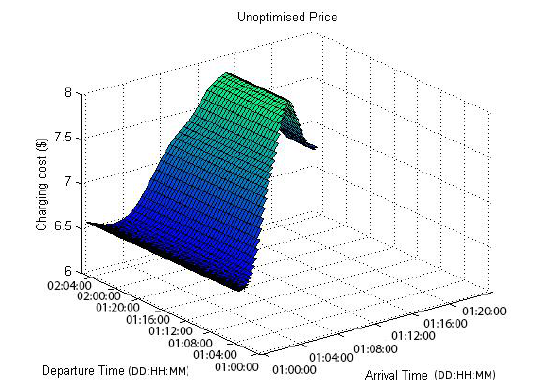
Figure 9: Non-optimised Charging